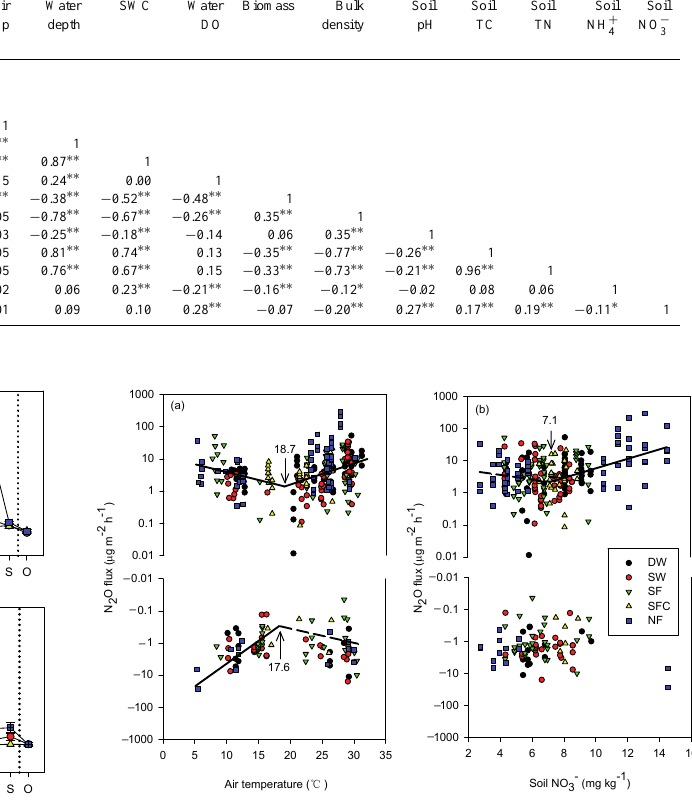
Figure 6. Relationship between flux, air temperature and soil NO − DW: deep water site; SW: shallow water site; SF: seasonally flooded site; SFC: “control site” for the seasonally flooded site; NF: non- flooded site. The result of piecewise correlation was plotted using flux data after log10 transformation. Dashed lines indicate insignif- icant correlations while solid lines indicate significant